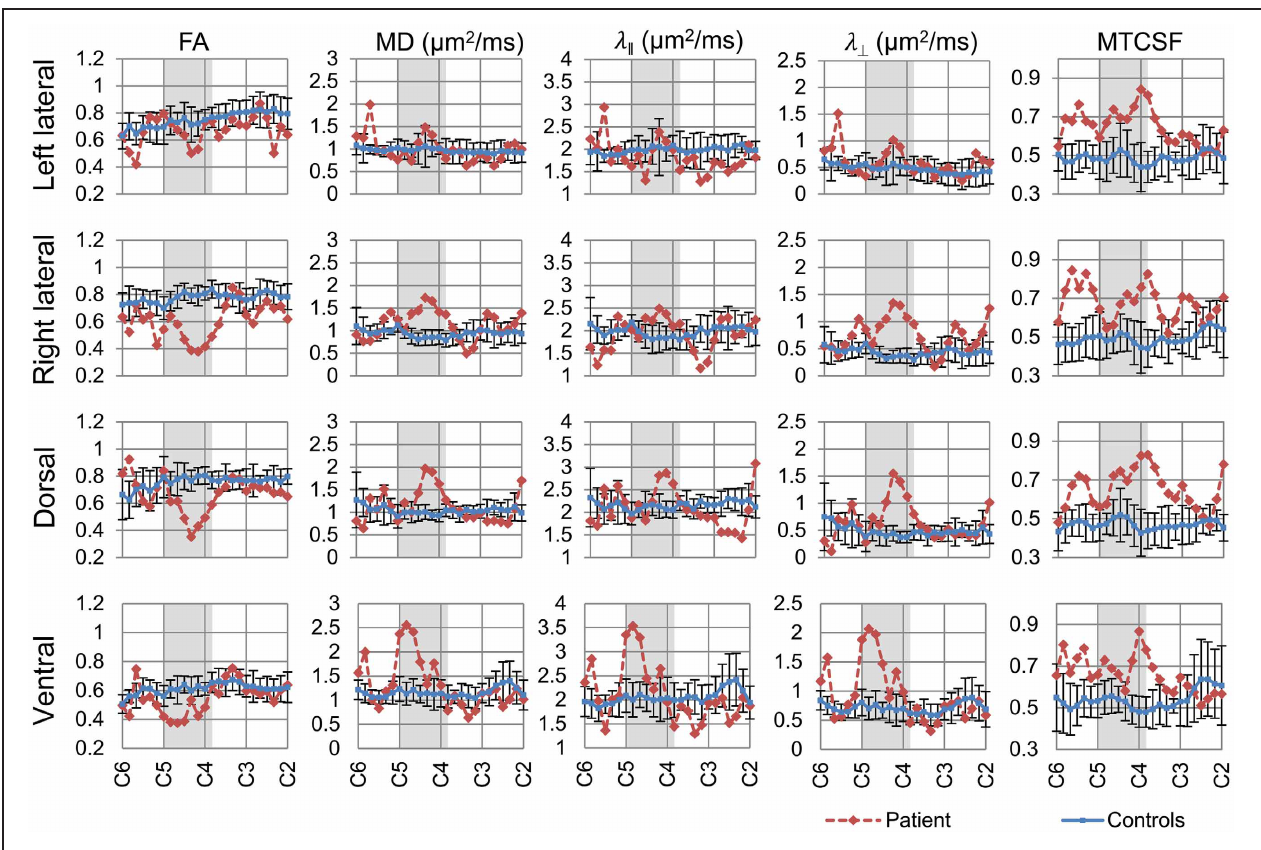
within the plots indicates the patient’s injury epicenter. Values reported for the controls are mean ± SD. FA value decreased, while MD, λ (cid:3) , and λ ⊥ increased at the injury epicenter. MTCSF value increased throughout the cervical